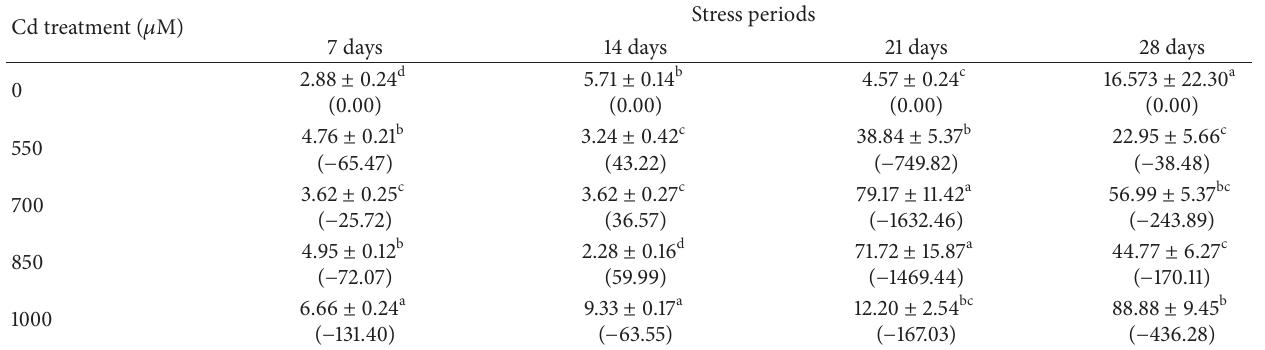
Table 9: CAT activity (U/g FW) of cotton callus culture (cv. YZ1) grown under various levels of